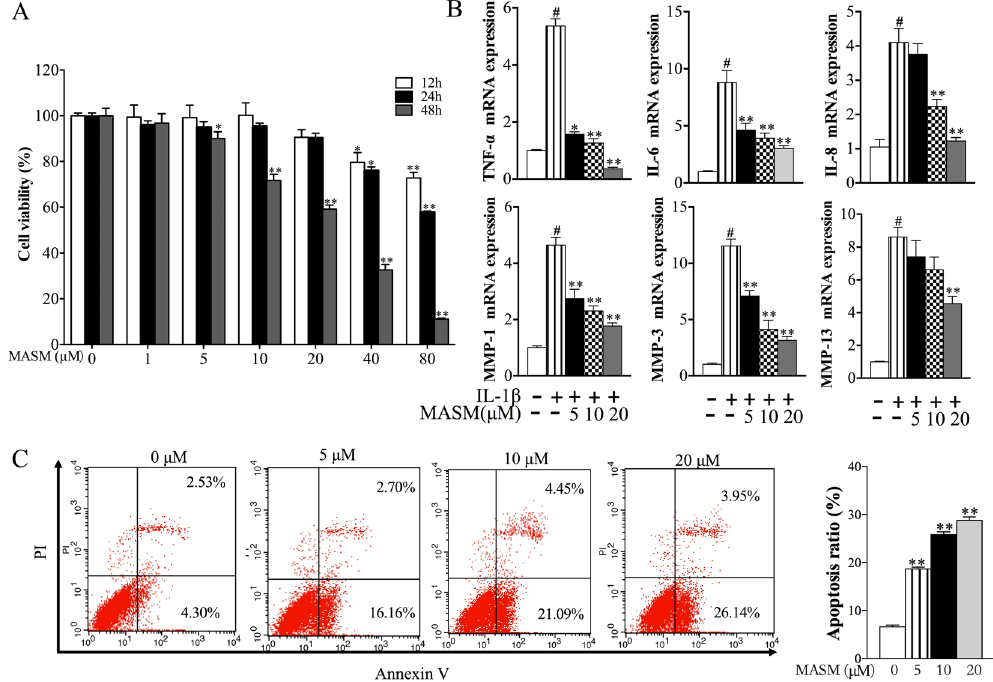
Figure 3. Effects of MASM on the IL-1 β -induced expression of pro-inflammatory cytokines and proteases in human RA-FLS and its effect on apoptosis of human RA-FLS. ( A ) Effects of MASM on cell viability. Cells were seeded in a 96-well plate (6 × 10 3 /well) and cultured with various concentrations of MASM (0, 5, 10,20, 40, 80, 160 μ M) for 12 h, 24 h and 48 h. ( B ) Effects of MASM on expression of pro-inflammatory cytokines (TNF- α , IL- 1 β , and IL-6) and proteases (MMP-1, MMP-3, MMP13) in human RA-FLS. Human RA-FLS were pre-treated with different concentrations of MASM (0–20 μ M) for 1 hour and then treated with 2 ng/ml IL-1 β for another 24 h. ( C ) Effects of MASM on apoptosis of human RA-FLS. Human RA-FLS were pre-treated with different concentrations of MASM (0–20 μ M) for 1 hour and then treated with 2 ng/ml IL-1 β for another 48 h. Apoptosis in human RA-FLS was assessed using Annexin V-FITC/PI double staining and analyzed by flow cytometry. The bars show the mean ± SEM from 3 independent experiments. ( A ) * P < 0.05, ** P < 0.01 versus RA-FLS in the absence of MASM treatment. ( B , C ) # P < 0.01 compared to the control RA-FLS. * P < 0.05, ** P < 0.01 versus RA- FLS stimulated with IL-1 β in the absence of